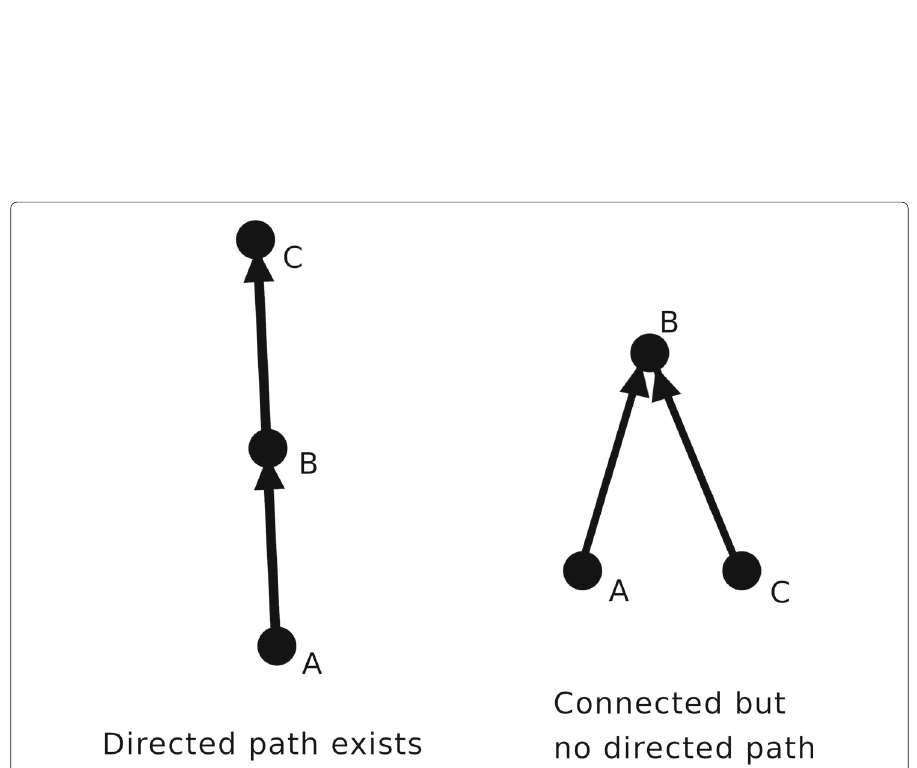
Fig. 4 Illustration of how DMDS (direction-aware multi-dimensional scaling) works. Left : d ( A , C ) = 2 with d ( A , B ) = d ( B , C ) = 1 from definition (2) so that the MDS would give a linear configuration. Right : d ( A , C ) = d ( A , B ) = d ( B , C ) = 1, which would give a triangular